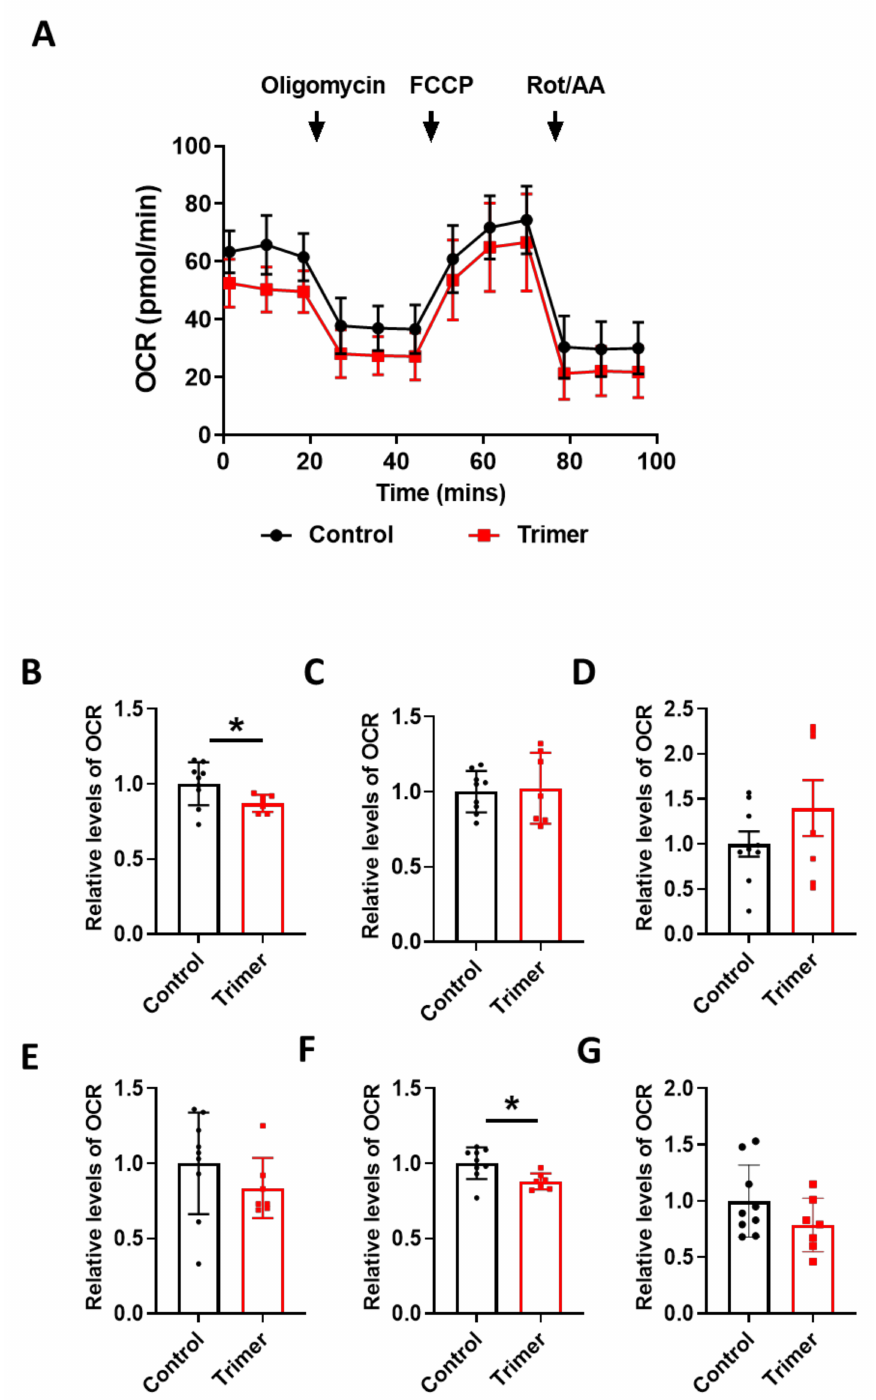
Figure 6. Active trimer spike protein alters basal respiration and ATP production of mitochondria in the human brain ECs. ( A ) Mito stress test was performed with the treatment of active trimer (Trimer) (15 nM), followed by injection: 2.5 µ M oligomycin; 2 µ M FCCP; 0.5 µ M Rotenone/Antimycin. ( B – G ) Parameters are calculated by Wave software program ( Agilent ) and normalized by non-treated control indicating basal respiration ( B ), maximal respiration ( C ), spare respiratory capacity ( D ), proton leak ( E ), ATP production ( F ), and non-mitochondrial respiration ( G ). Data were quantified by unpaired student t -tests, and error bars show means with SD (N ≥ 7). * p <